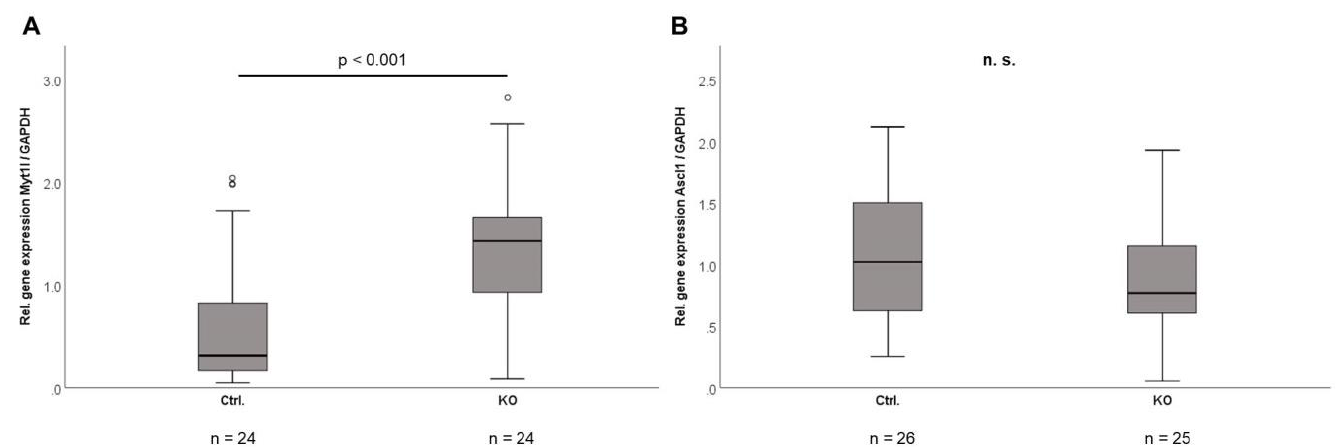
Figure 6. Gene expression analysis of Myt1l and Ascl1 in adipose tissue. Intra-abdominal adipose tissue was obtained from CTRP-3 KO mice and littermate control animals. Gene expression levels were determined by real-time PCR and were normalized to GAPDH levels. GAPDH , glyceraldehyde-3-phosphate dehydrogenase; Ascl1 , achaete-scute family BHLH transcription factor 1; Myt1l , myelin transcription factor 1-like. ◦ , outlier